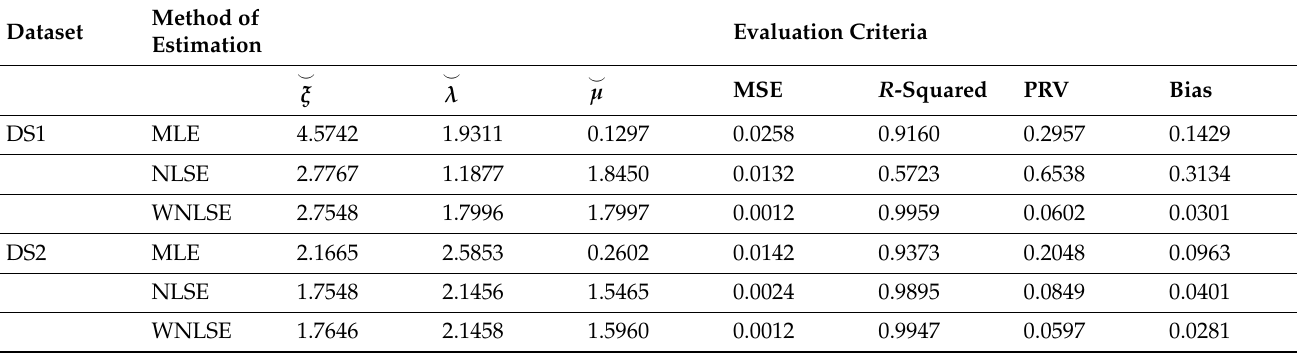
Table 2. Estimated values of parameters and assessment metrics of the NHPP–NPF